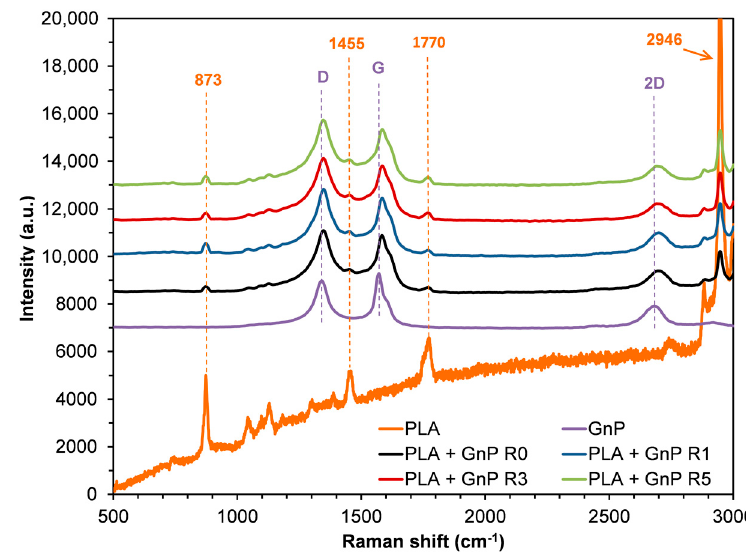
Figure 5. Raman spectra of neat GnP, PLA R0 and PLA + GnP nanocomposites at different reprocessing cycles.